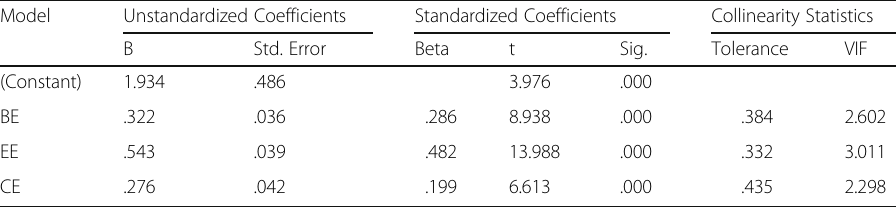
Table 6 Multiple regression analysis results of engagement components on perceived learning